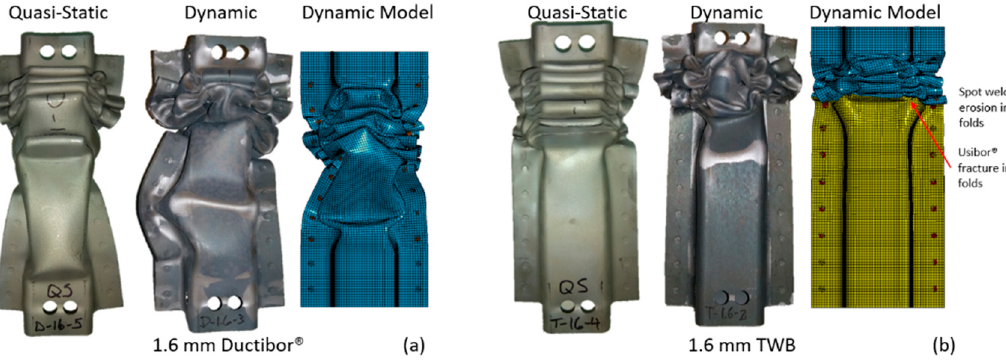
Figure 5. Crushed rails from quasi-static, dynamic experiments and model in ( a ) Ductibor ® 500-AS and ( b )